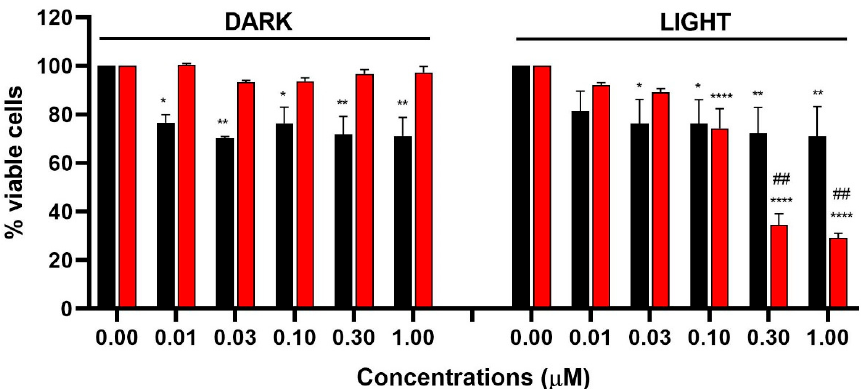
Figure 9. Cell viability of CAL27 cells after 24 h from 45 min treatment with increasing concentrations of mTHPC/CM (black bars) or mTHPC@apoMb (red bars), and in the presence or absence of 45 min of light irradiation. Statistical significance was calculated by one-way ANOVA followed by Dunnett’s multiple comparisons test or t -test. * p < 0.05, ** p < 0.001; **** p < 0.0001 compared to untreated cells; ## p < 0.01 compared to the same concentration of treatment with mTHPC/CM after light exposure.